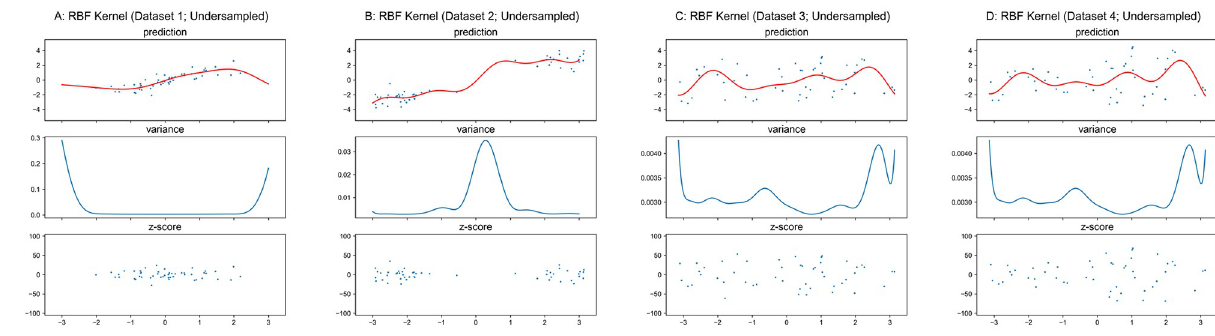
Fig 7. GPR with RBF kernel on undersampled datasets. Scales of Y-axis for variance plots are different.